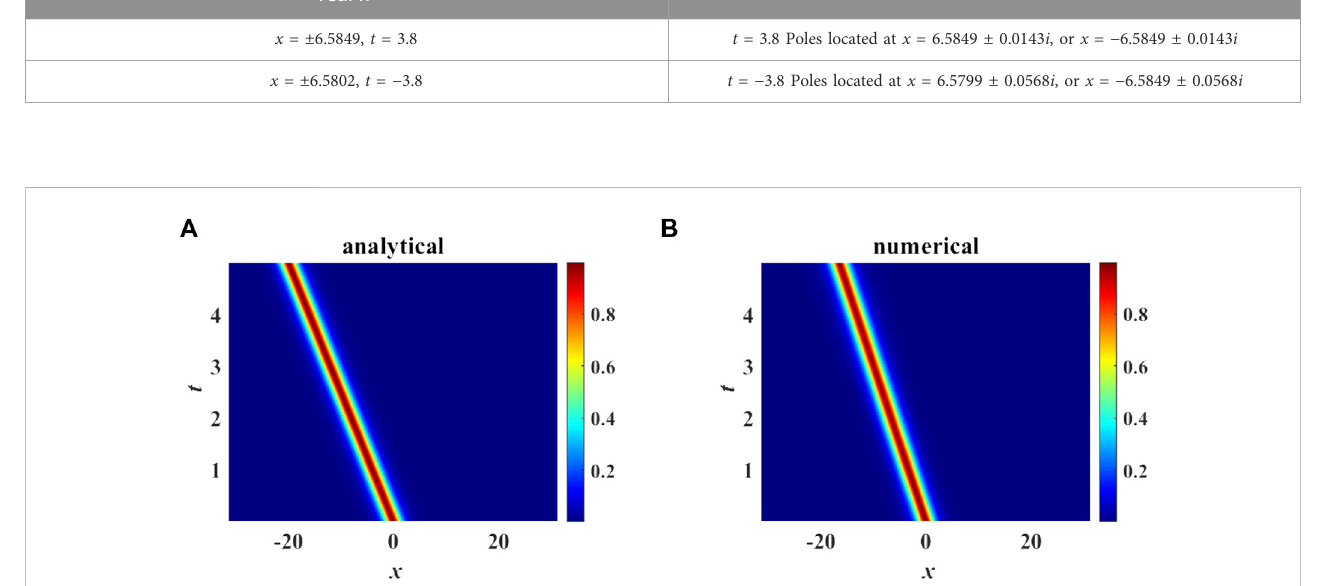
TABLE 1 Comparison of the locations of maximum displacements in Figure 2B and the locations of poles of Eq. 17 with N = 2. Locations of the maximum (maxima) in the physical space with real x